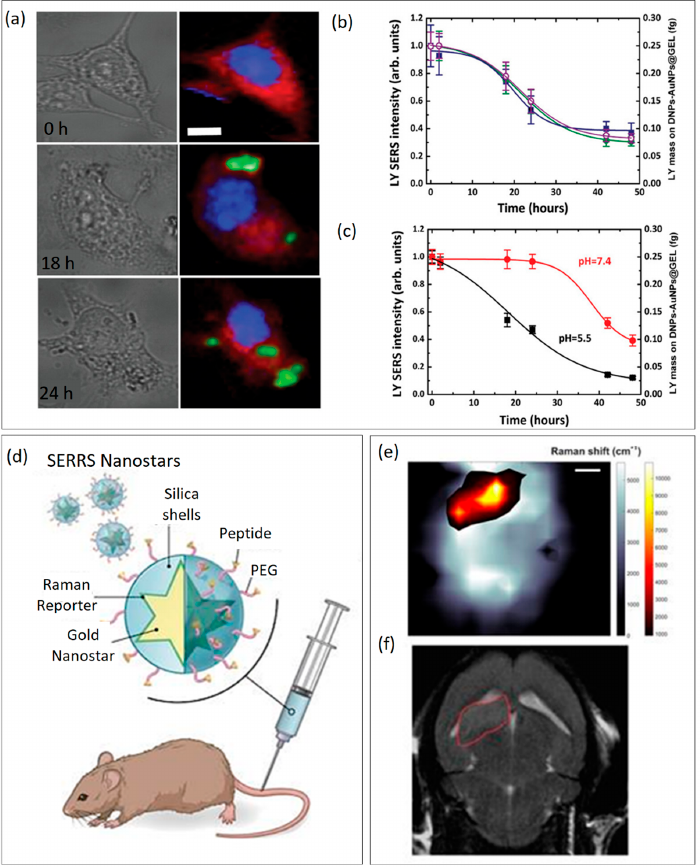
Figure 2. ( a ) False map reconstructed by Raman imaging through the MCH approach for analyzing the internalization of hybrid DNPs in cells. ( b ) Drug release studies monitored in CRC cells by re- al-time SERS. ( c ) Drug release studies monitored in phosphate buffered saline (PBS) pH 7.4 and 5.5 by real-time SERS. Adapted with permission from Ref. [75]. Copyright (2021), John Wiley & Sons. ( d ) Functionalization of active-targeted nanostars for in vivo imaging of brain tumors. ( e ) The SORS heat map confirming the presence of a brain tumor is in good agreement with the MRI image ( f ). Adapted with permission from Ref. [91]. Copyright (2019), Ivyspring International Publisher.